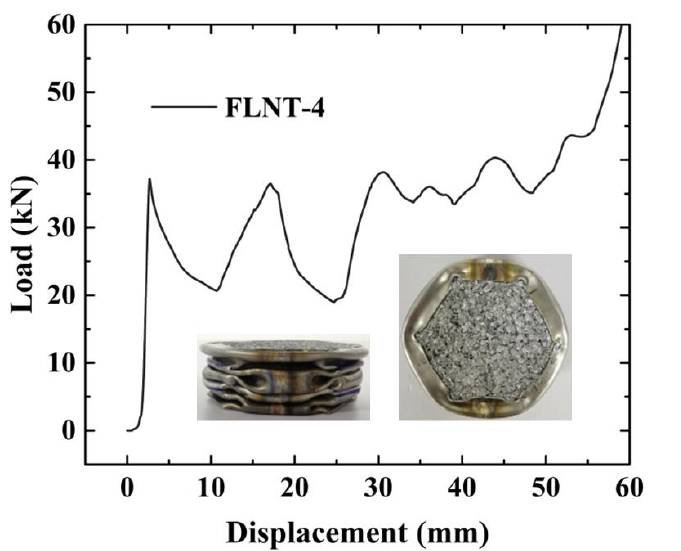
Figure 20. Load – displacement relation for FLNT under compression test. Figure 20. Load–displacement relation for FLNT under compression test.